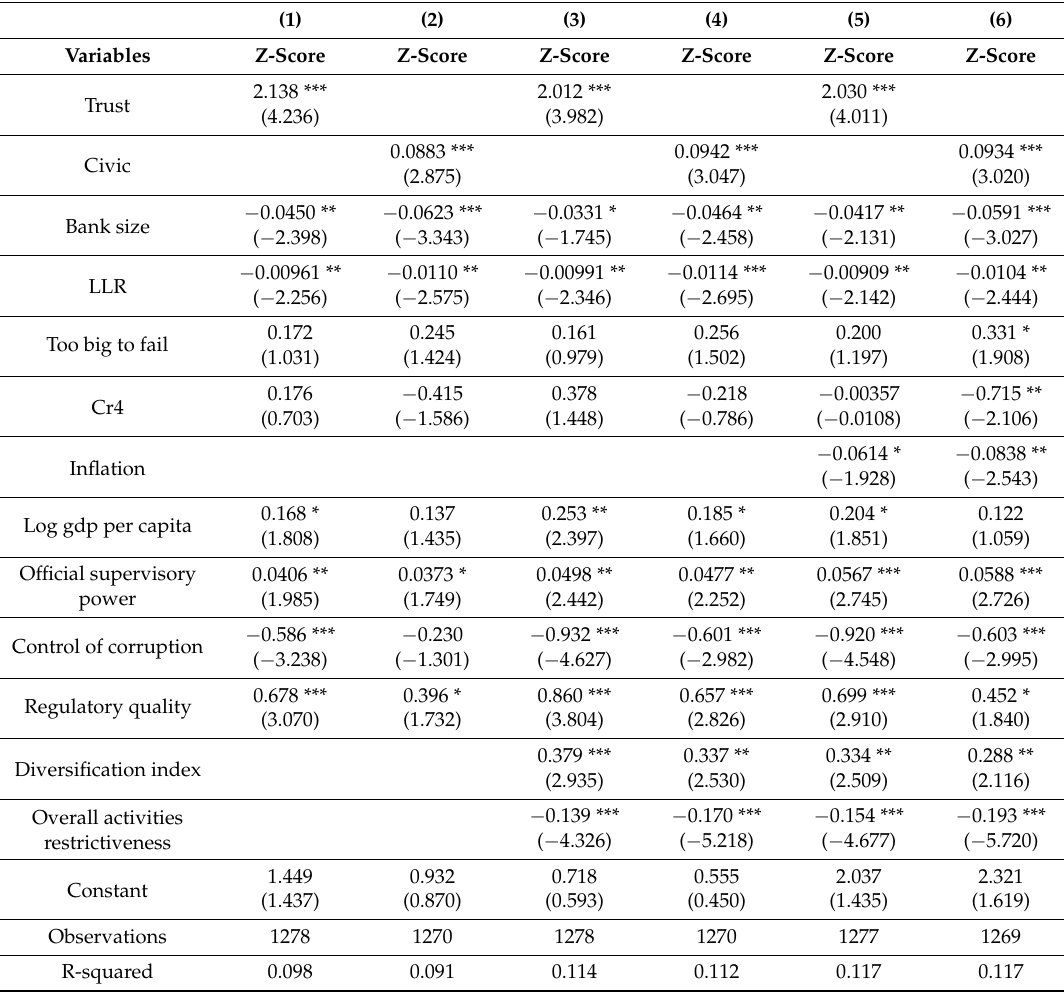
Table A3. Additional